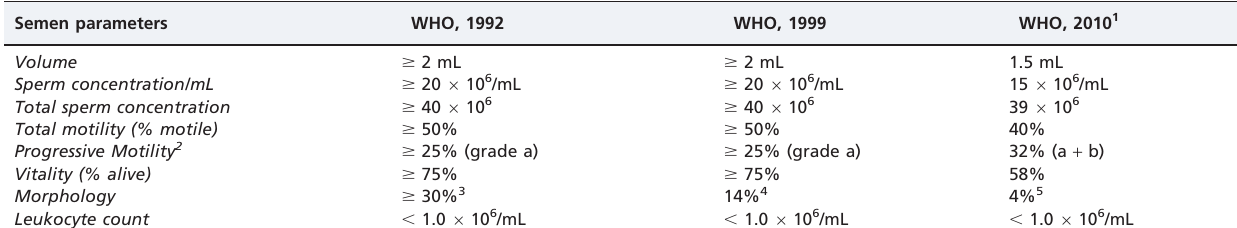
Table 3 - Reference Values for Semen Parameters, as Published in Consecutive WHO